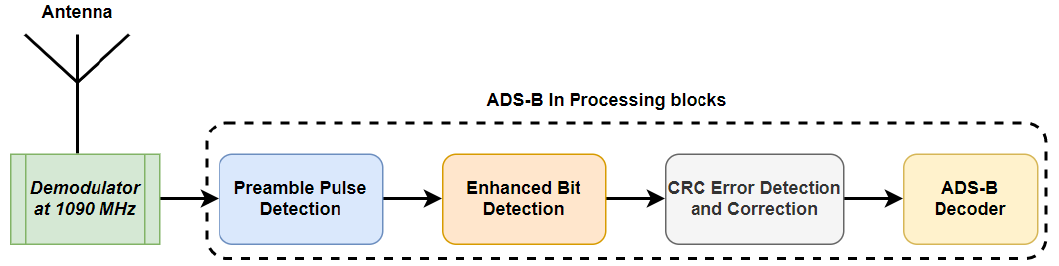
Figure 1. The high-level structure of ADS-B In signal processing .